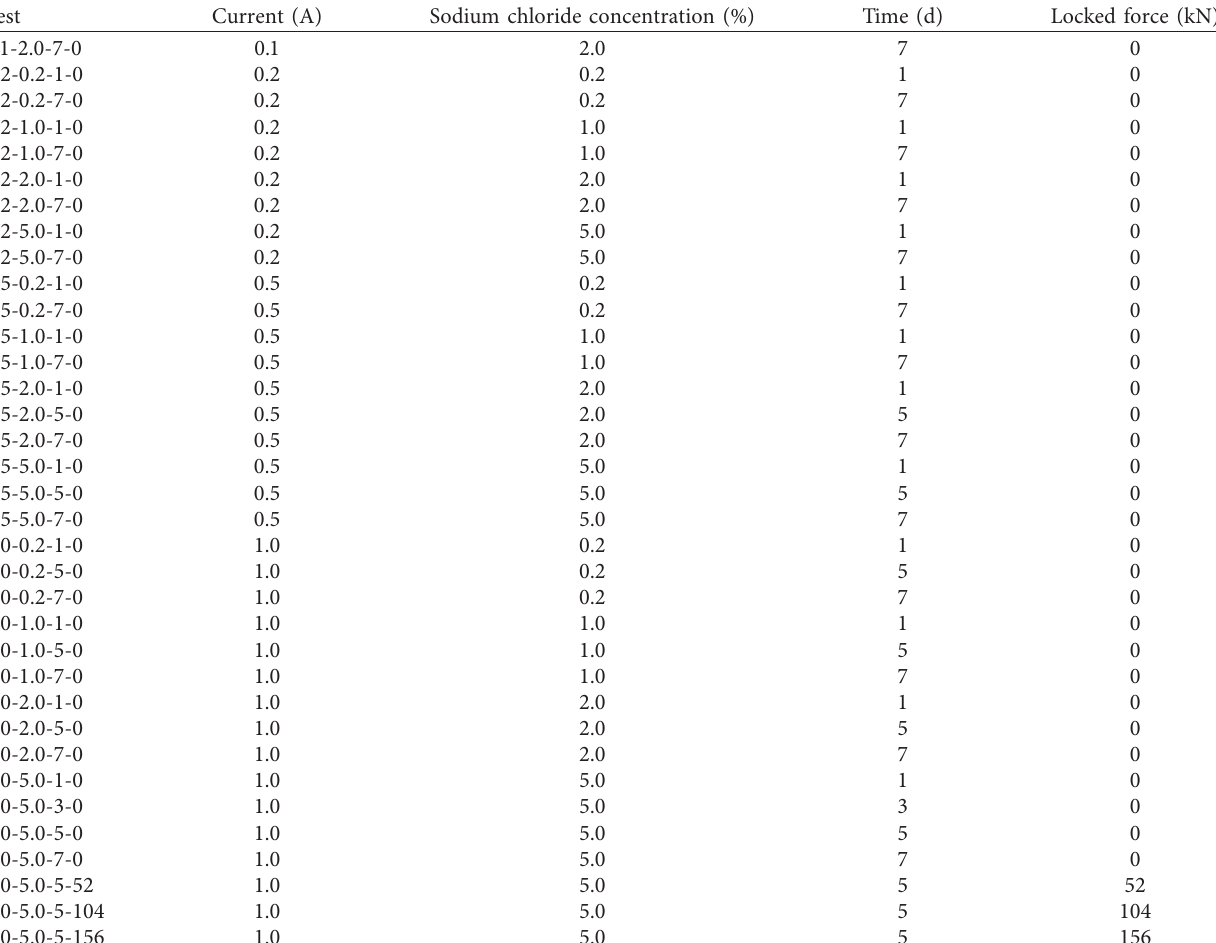
Table 2: Summary of anchor cable electrolytic corrosion